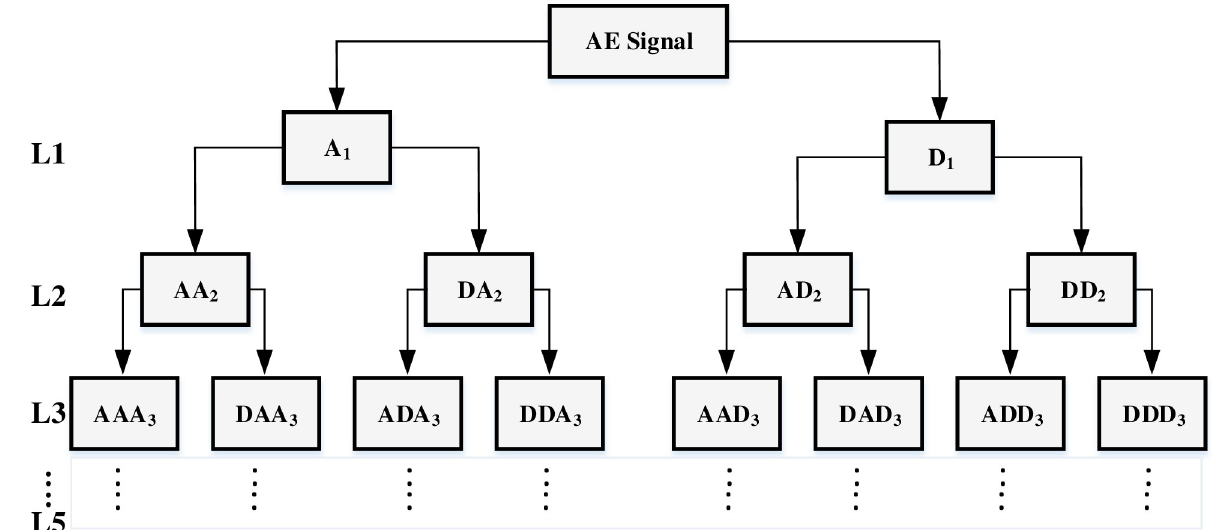
Fig 7. Five-layers wavelet packet decomposition tree.